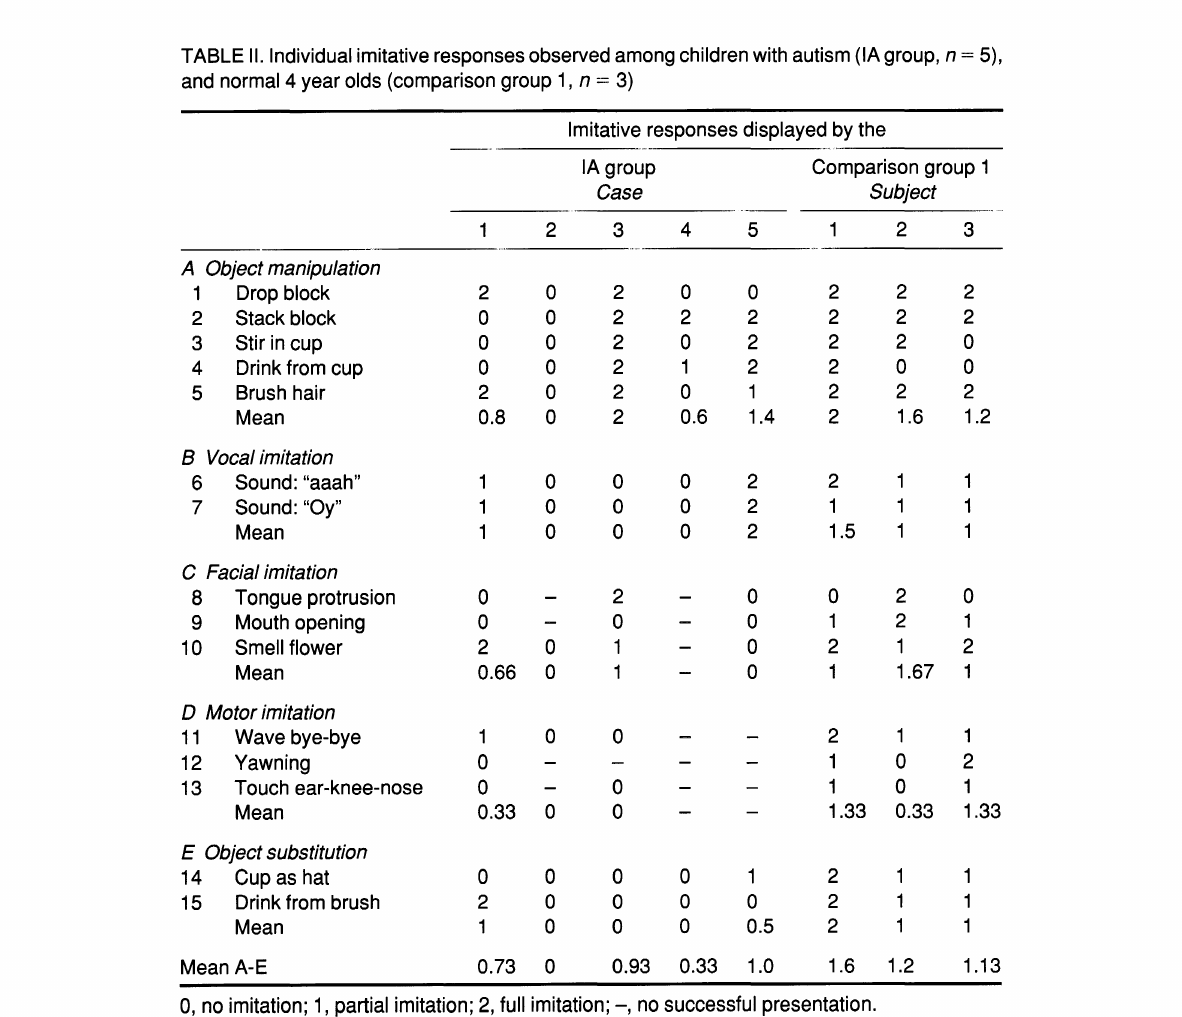
TABLE II. Individual imitative responses observed among children with autism (IA group, n = 5), and normal 4 year olds (comparison group 1, n O~ 3) Imitative responses displayed by